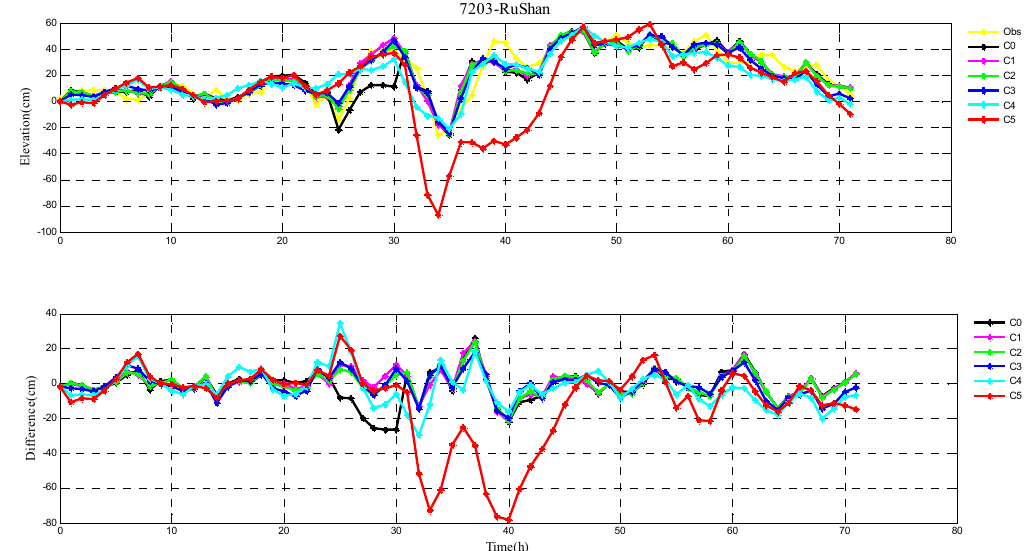
Figure 4. The storm surge elevations (cm) in six cases (C0, C1, C2, C3, C4, C5) and observations (yellow line) (top) and the differences between them (bottom) during Typhoon 7203 at QinHuangDao tide station.